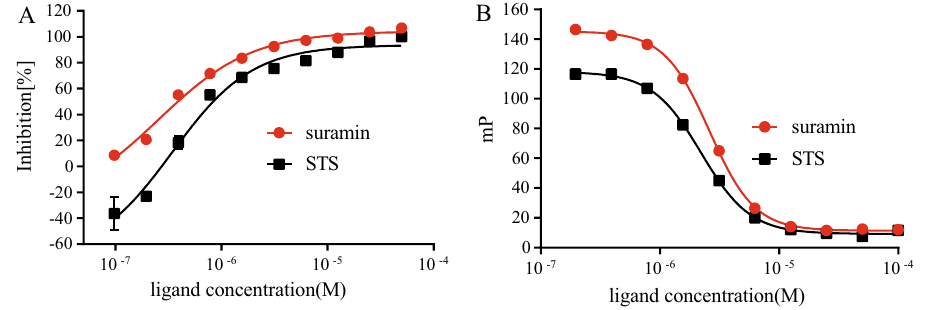
Figure 3. STS inhibits FHIT hydrolase activity through occupation of FHIT substrates binding pocket. ( A ) STS significantly inhibited FHIT Ap3A hydrolase activity (black square) with IC50 = 0.34 ± 0.09 µM, the IC50 of suramin (red circle) was 0.26 ± 0.08 µM. ( B ) In fluorescence polarization assay, the IC50 was 2.2 ± 0.05 µM for STS (black square) and FHIT H96N-ApppBODIPY binding inhibition, and the IC50 was 2.6 ± 0.044 µM for suramin (red circle).